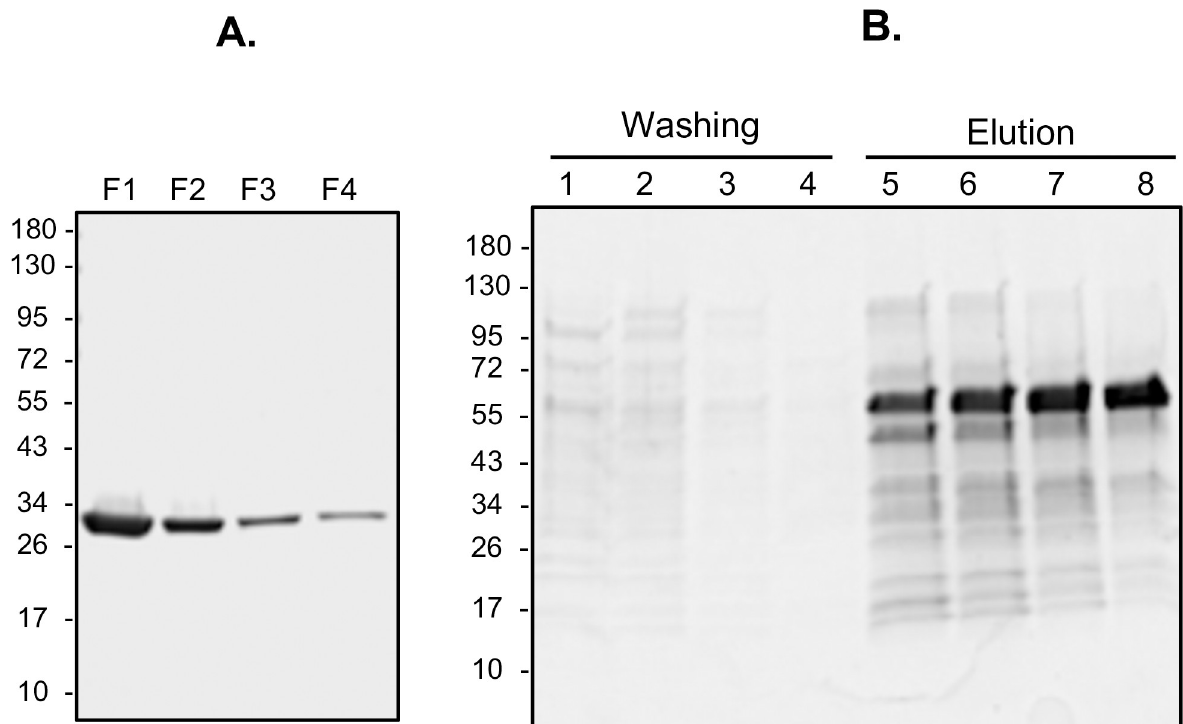
Fig 2. TbLysoPLA and TbGK proteins purification. Purification of TbLysoPLA (A.) by affinity chromatography on GE glutathione sepharose 4B. Lanes F1-F4 correspond to the collected fraction after GST release by thrombin cleavage. Nickel affinity purification of TbGK-6xHis fusion protein (B.) on HisPur Ni-NTA resin. Lanes 1–4: washes; lanes 5–8: imidazole elution fractions.